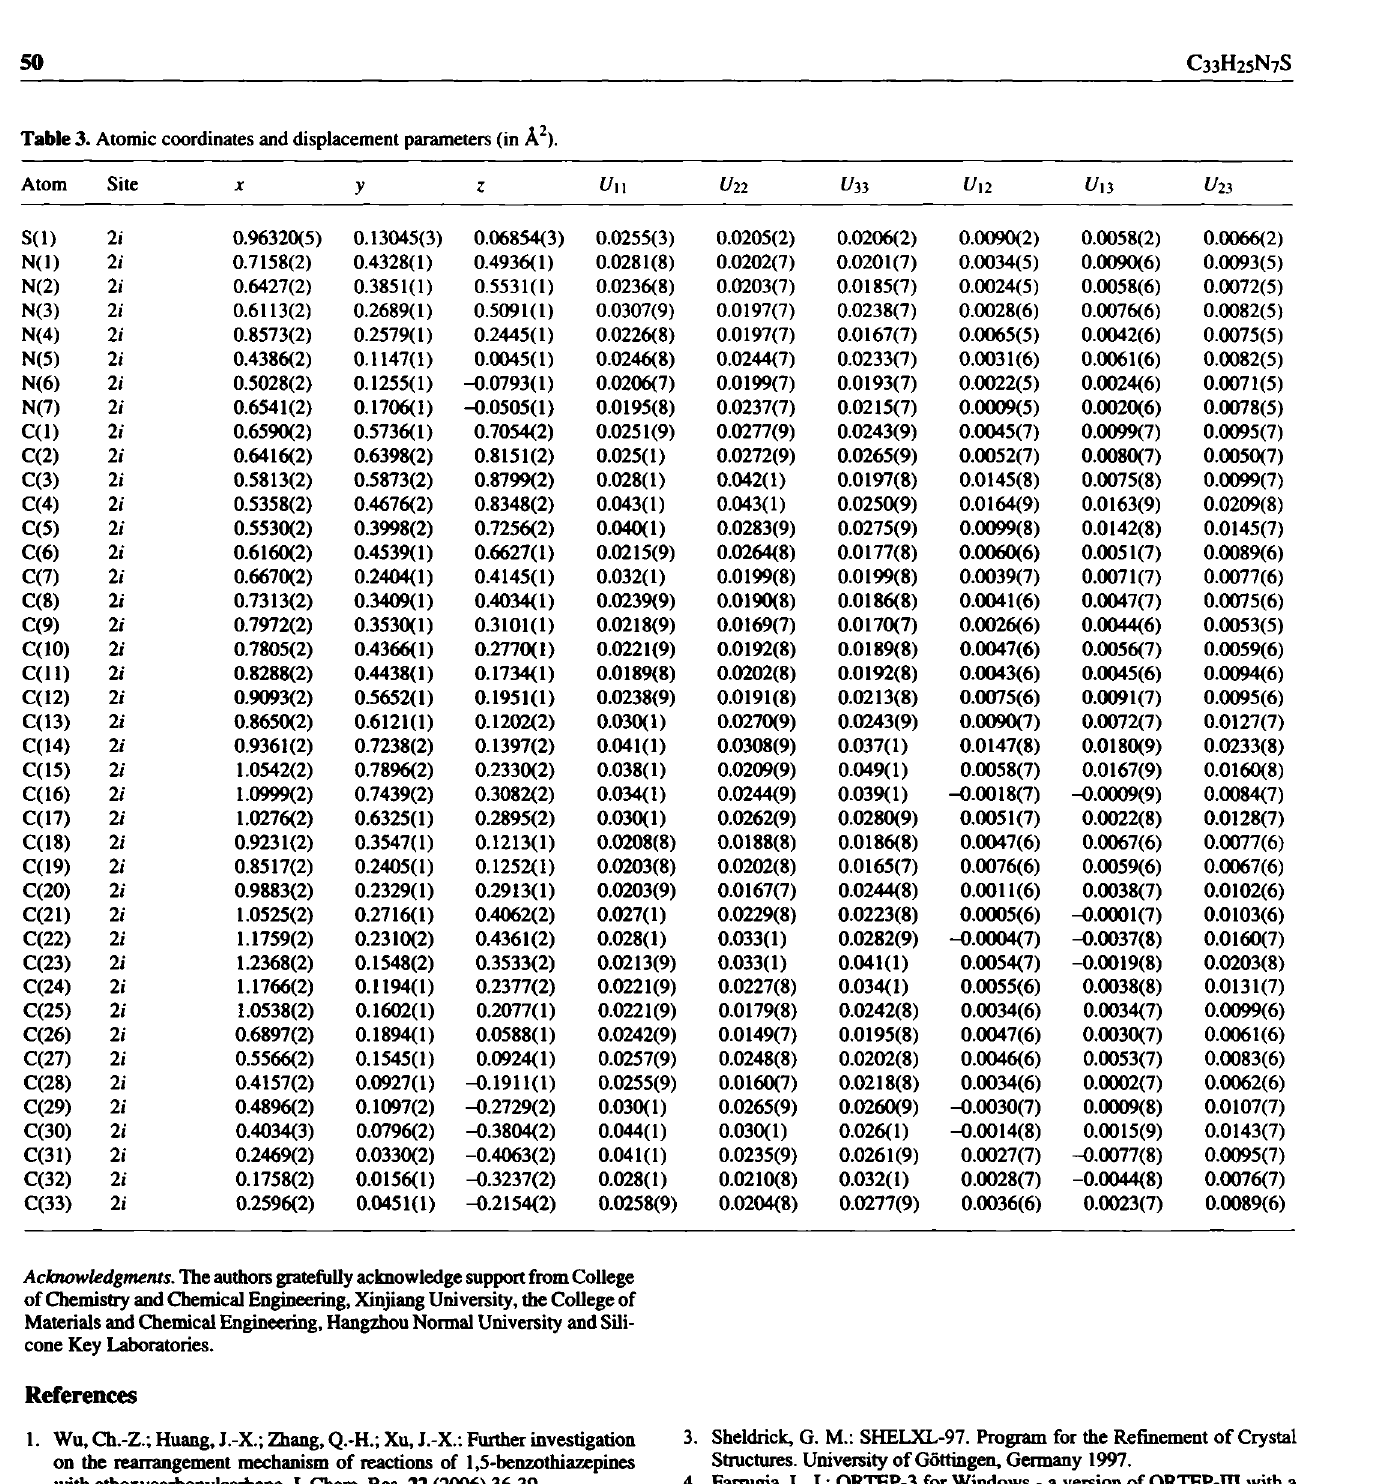
Table 3. Atomic coordinates and displacement parameters (in Â 2